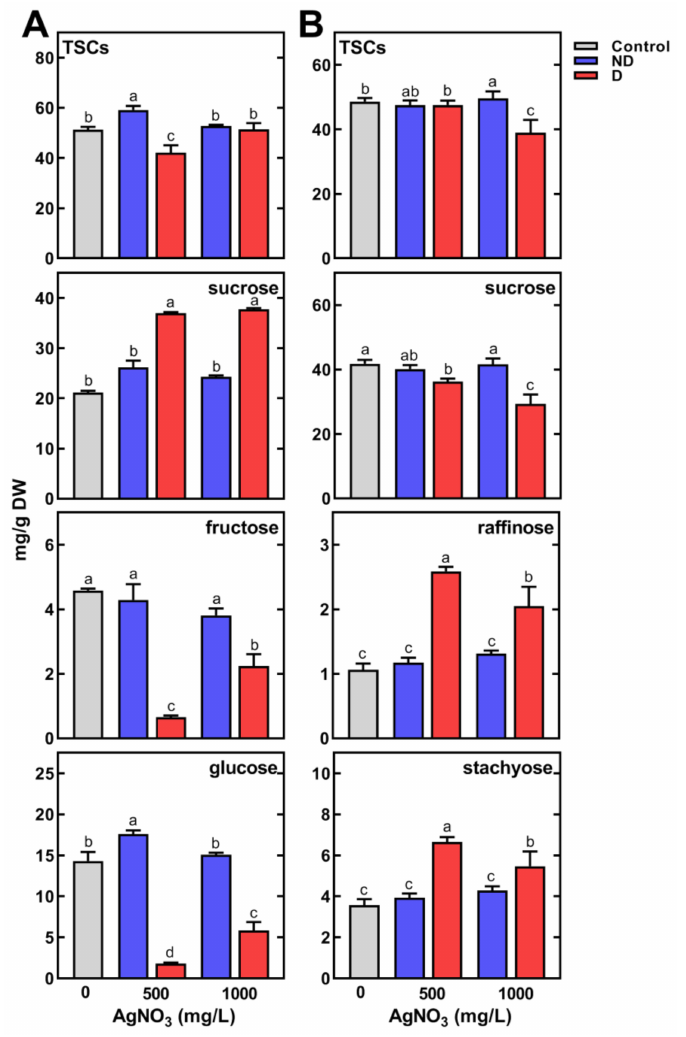
Figure 6. The effect of pea seeds imbibition for 8 h with AgNO 3 at concentrations of 0, 500 and 1000 mg/L on the content of total soluble carbohydrates (TSCs) and selected carbohydrates in control, non-deformed (ND) and deformed (D) sprouts ( A ) and cotyledons ( B ) of 4-day-old seedlings. Results are means ( n = 3) + SD. Bars marked with the same letters (a–d) are not significantly different after one-way ANOVA and Tukey post hoc